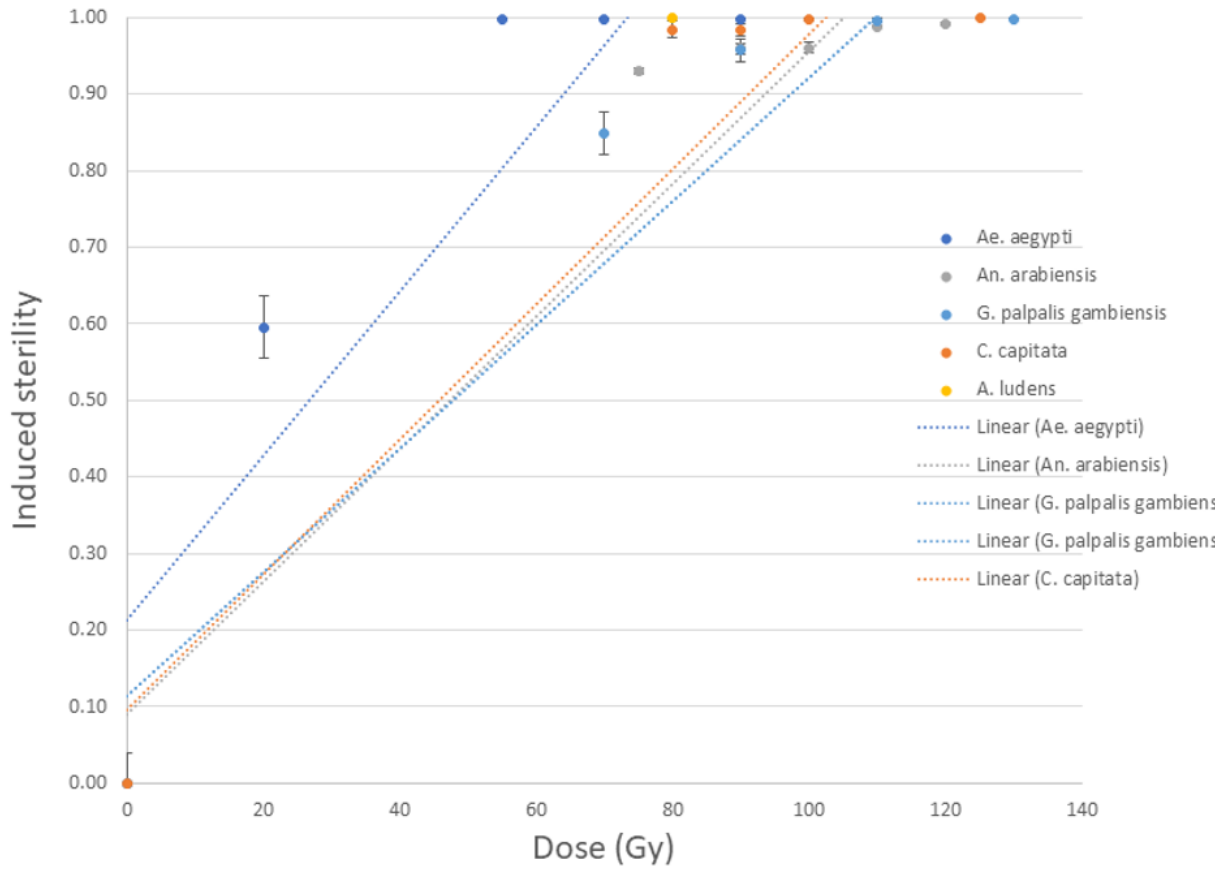
Figure 1. Induced sterility of pupae of five insect species in response to increasing irradiation doses in an MK2 irradiator. * A. ludens was subjected to only one dose.